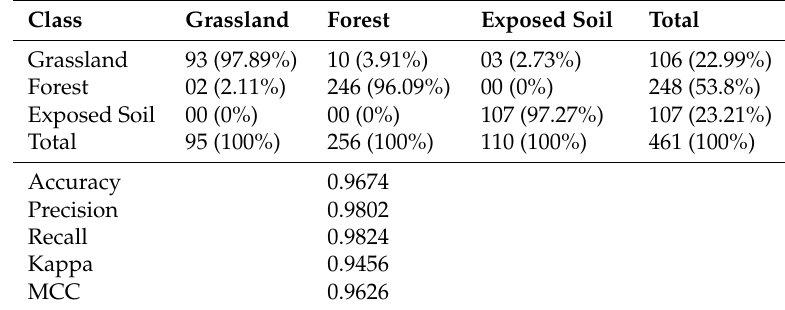
Table 9. Landsat 8 image classification confusion matrix and evaluation measures. The percentage values are related to the number of classified pixels in the